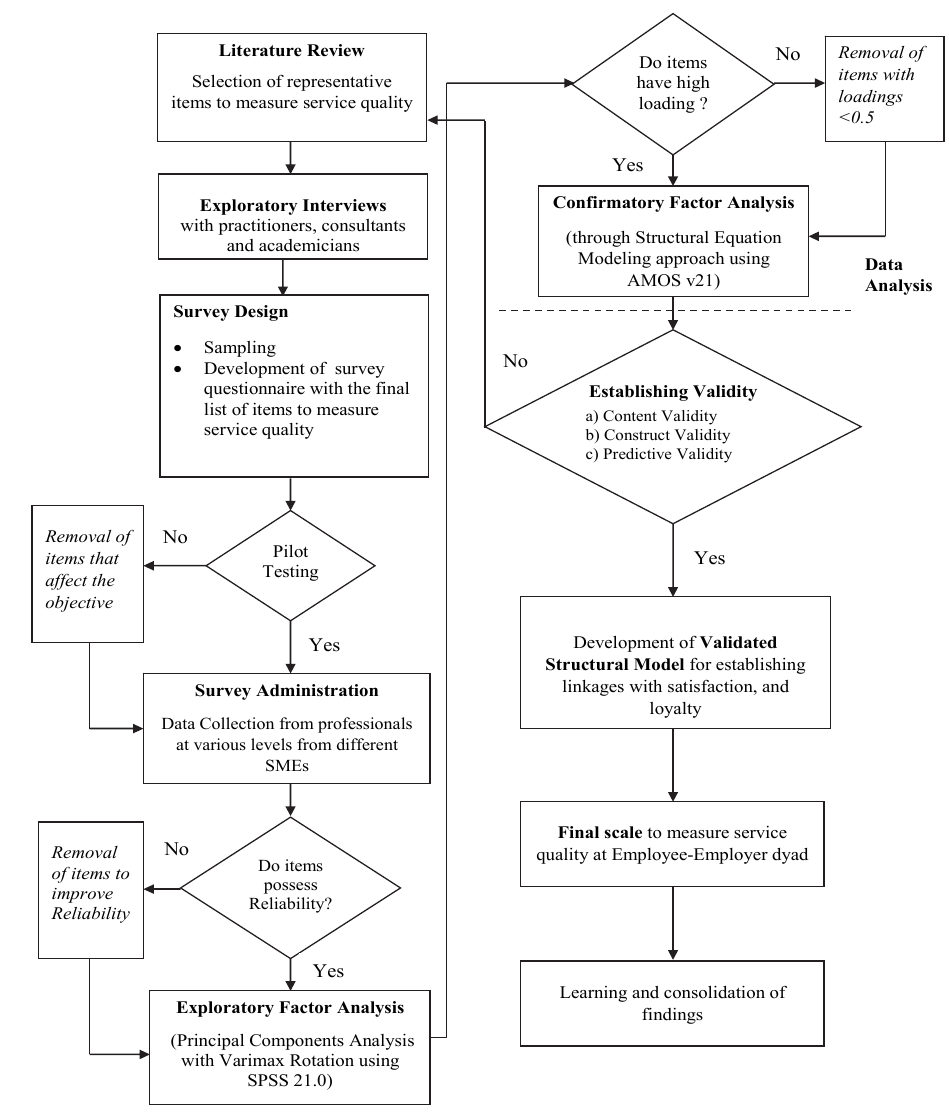
Fig. 2. Flow chart of research methodology adopted for measurement and modeling of service quality at Employer-Employee